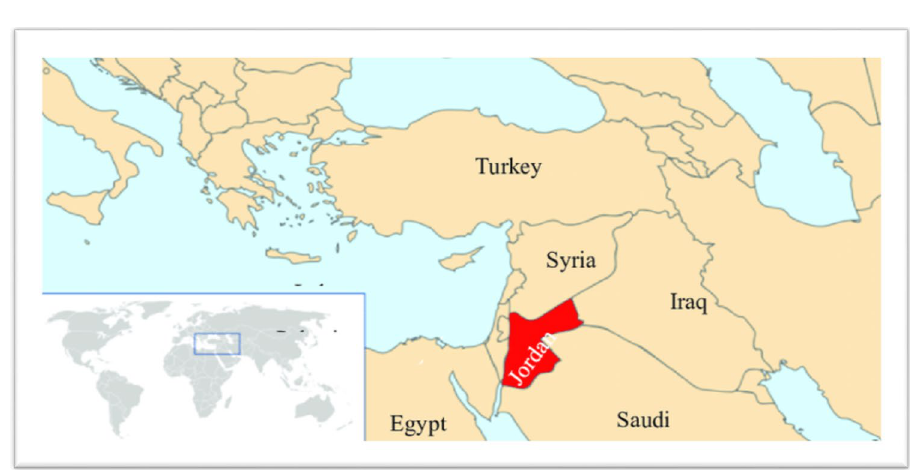
Fig. 1 Map of Jordan location in relation to nearby countries and the world [captured from Atlas of Jordan